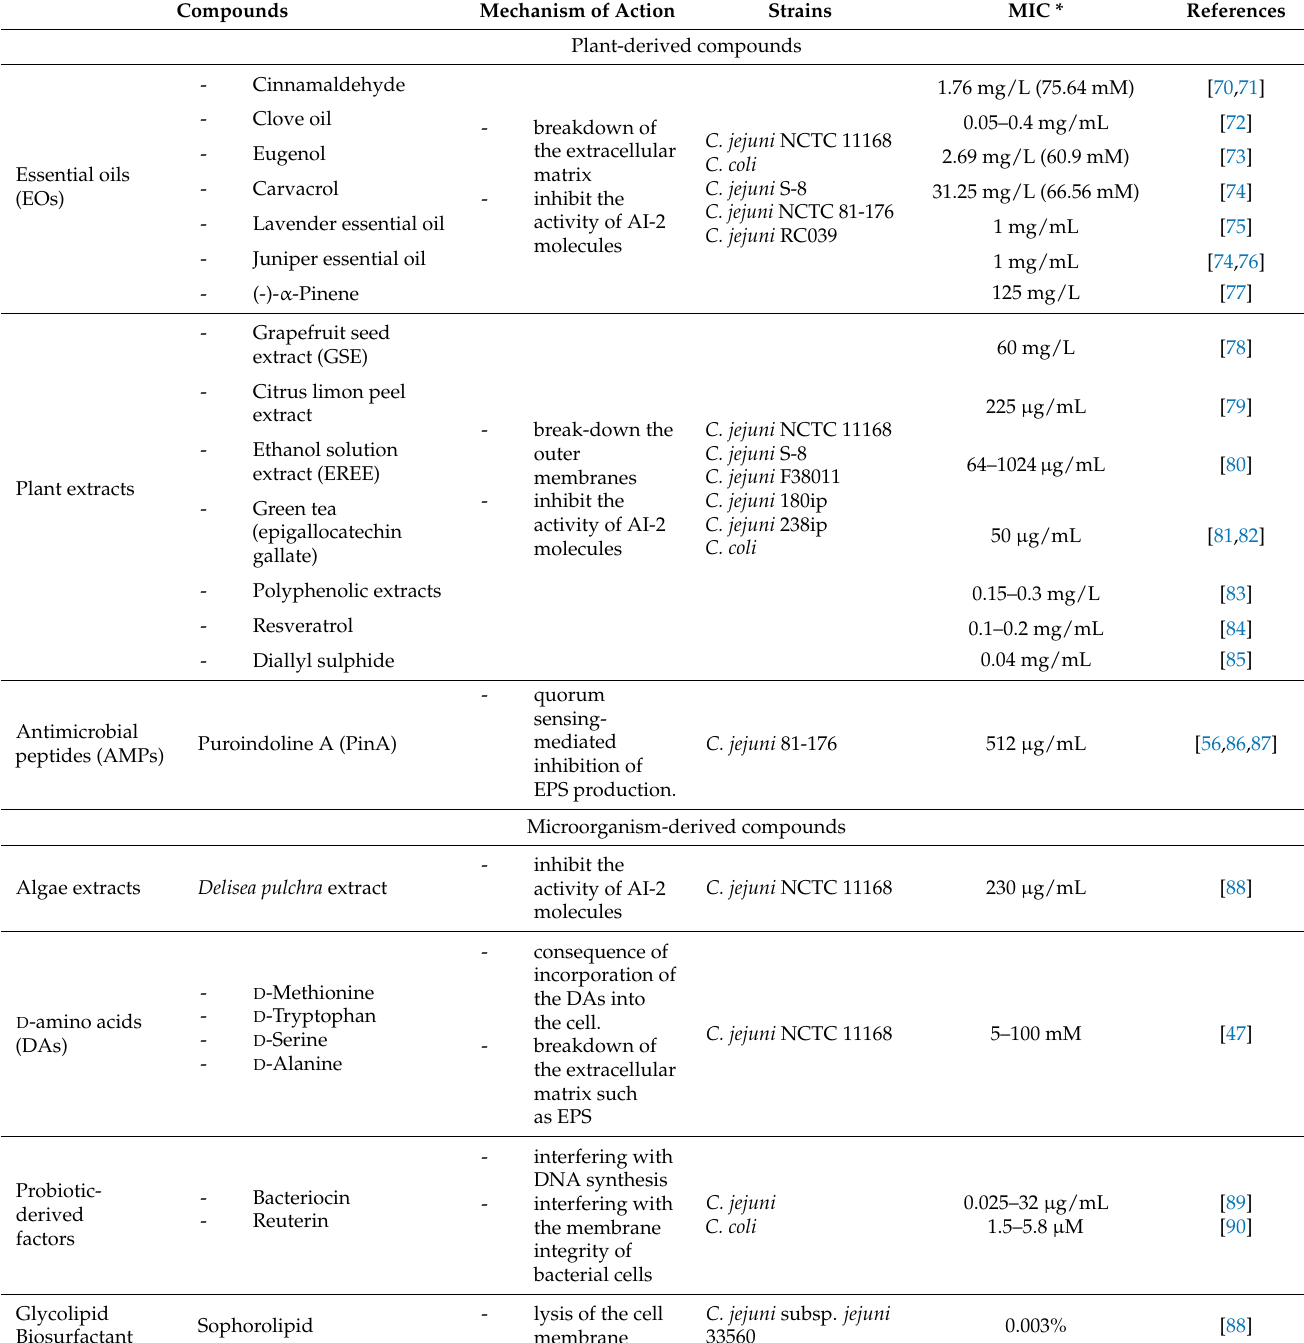
Table 1. Antibiofilm activity of natural compounds with their mechanism of